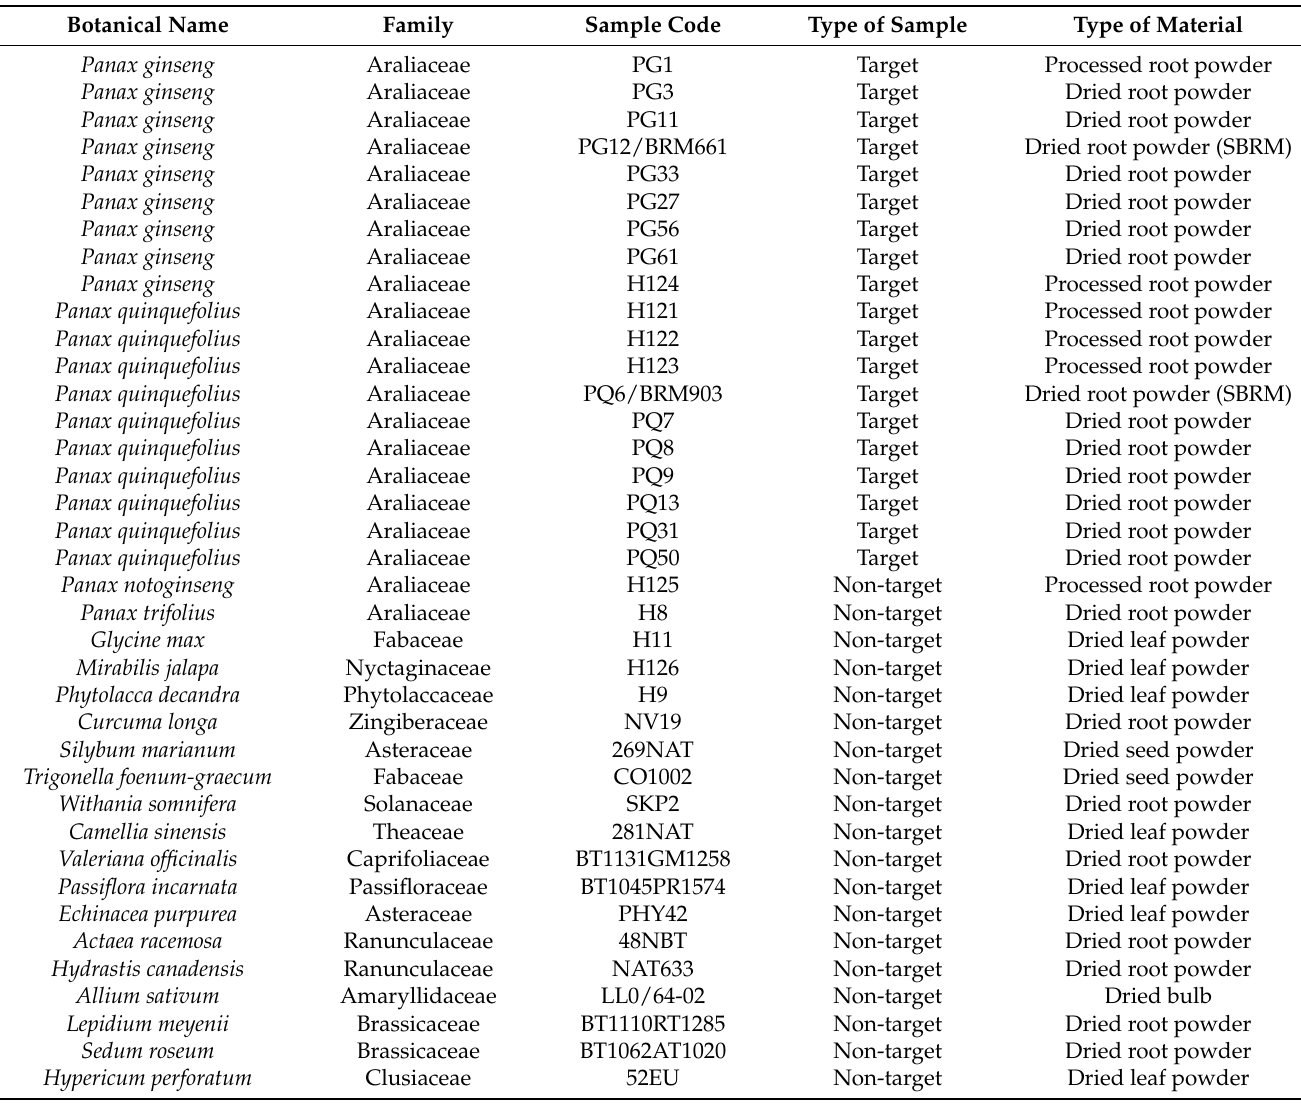
Table 1. Target and non-target species used for validation of P. ginseng and P. quinquefolius